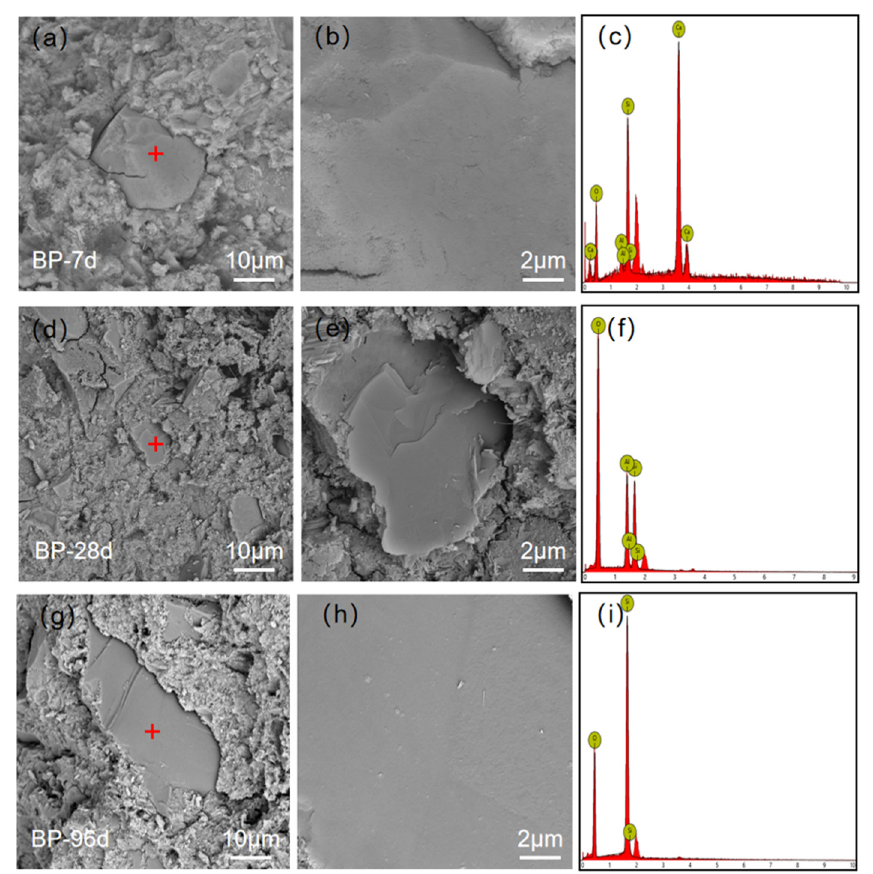
Figure 13. The fracture surface of the BP paste at 7 d ( a , b , c ), 28 d ( d , e , f ), 96 d ( g , h , i